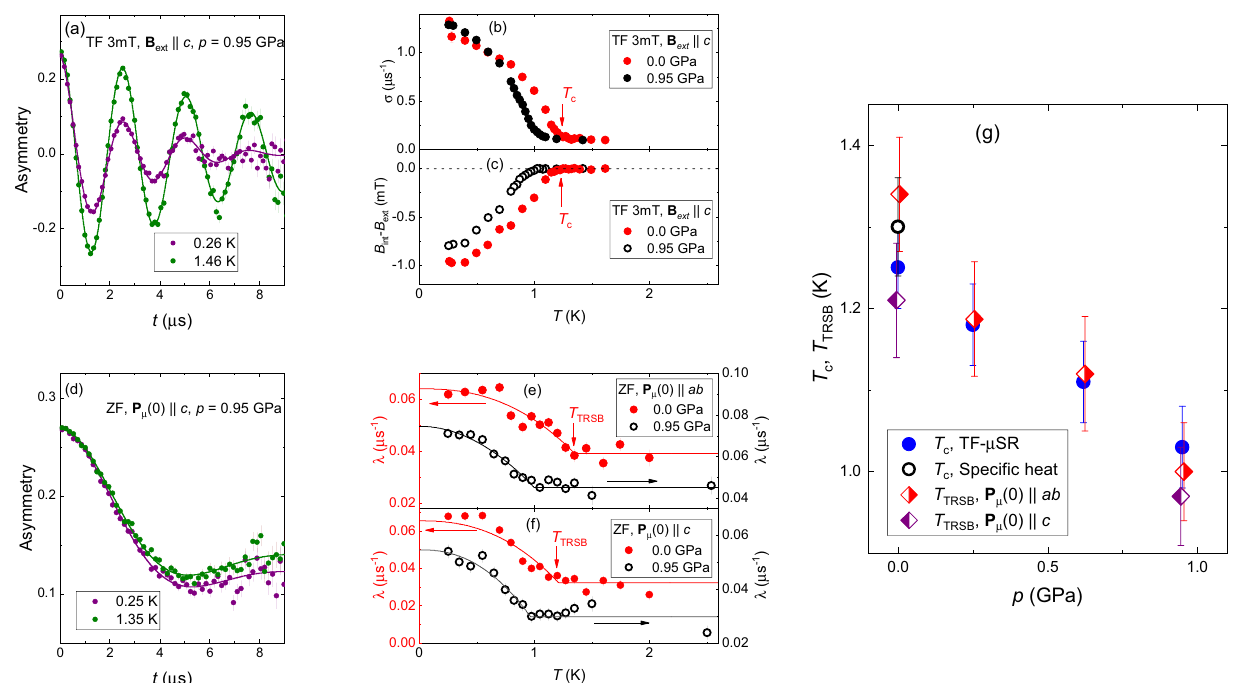
Fig. 2 Effect of pressure on T c and T TRSB in Sr 2 RuO 4 . a TF- μ SR time-spectra above and below T c measured at p = 0.95 GPa and B ext = 3 mT, with B ext ∥ c . The plotted quantity is the detection asymmetry between two positron detectors, which is proportional to the muon spin polarisation P μ ( t ). The solid lines are fi ts of Eq. (2), with the sample and the pressure cell contributions described by Eqs. (3) and (4), respectively. b , c Temperature dependencies of the Gaussian relaxation rate σ and the diamagnetic shift B int − B ext ∝ M FC at p = 0.0 and 0.95 GPa. Arrows indicate the position of the superconducting transition temperature T c at p = 0.0 GPa. d ZF- μ SR time-spectra above and below T c , measured at p = 0.95 GPa and with initial muon spin polarisation P μ (0) ∥ c . The solid lines are fi ts of Eq. (2), with the sample and the pressure cell parts described by Eqs. (5) and (7). e , f Temperature dependencies of the ZF exponential muon spin relaxation rate λ at p = 0.0 and 0.95 GPa. In e , P μ (0) ∥ ab , and in f , P μ (0) ∥ c . The solid lines are fi ts of Eq. (1) to the data. Arrows indicate the position of T TRSB at p = 0.0 GPa. g Dependence of T c and T TRSB on pressure. Open circle correspond to an average T c of 1.30(6) K determined from speci fi c heat data (see Supplementary Fig. 1 in Supplementary Note 1). The displayed error bars for μ SR data correspond to one standard deviation from the χ 2 fi t 71 . The displayed error bars for T c indicate the rounding of the transition on a scale of approximately 0.1 K. The error bars for μ SR data and T TRSB correspond to one standard deviation from the χ 2 fi t 71